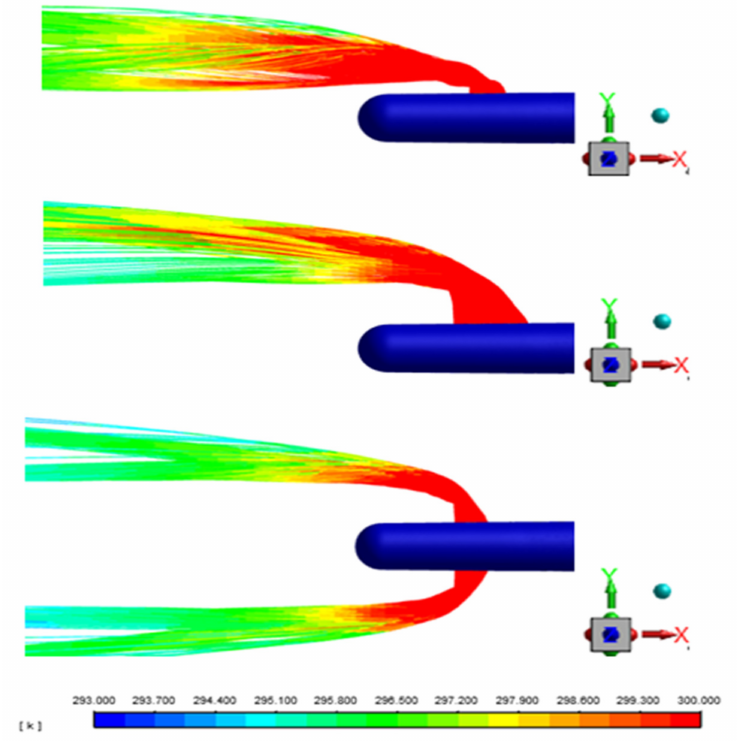
Figure 19. Flow streamline of the thermal jet from the discharge